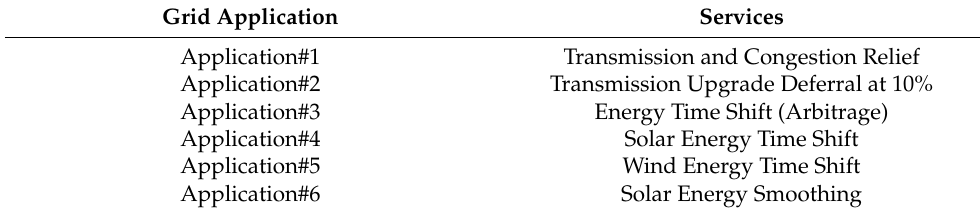
Table 1. List of priority services covered by the proposed ESS.